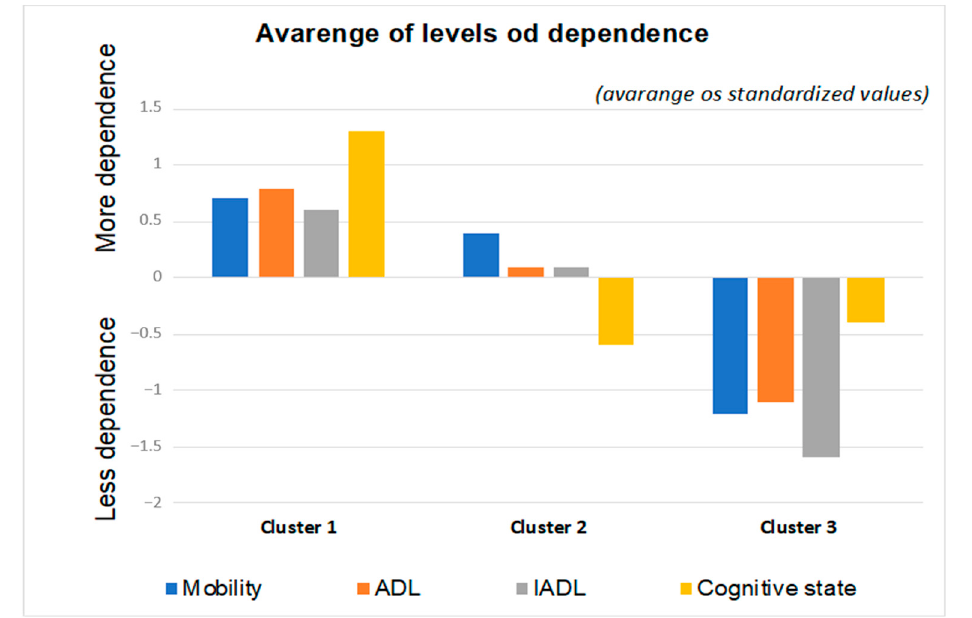
Figure 2. Mean dependence levels for Cluster 1, Cluster 2 and Cluster 3 in the convalescence units.